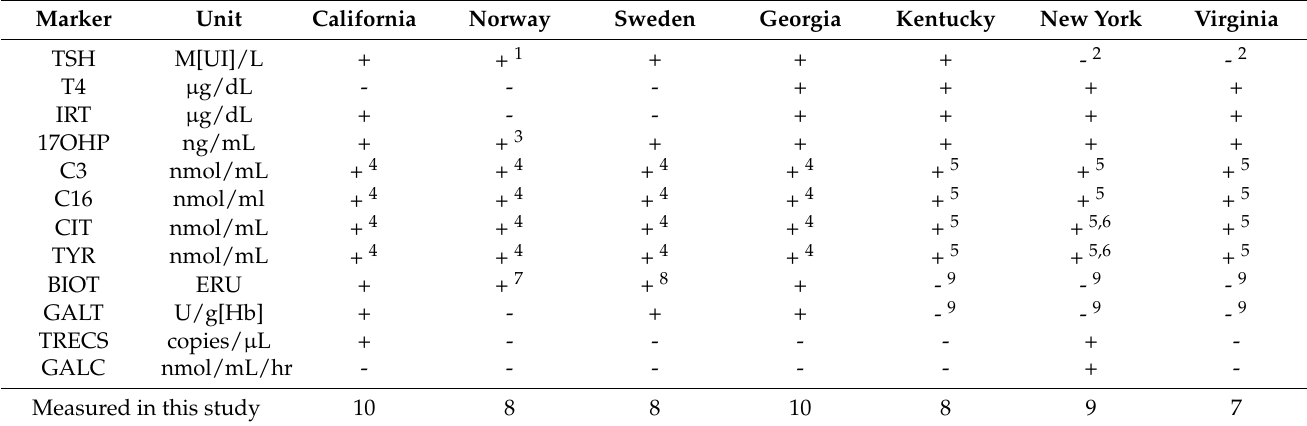
Table 1. First tier markers contributed by participating locations.